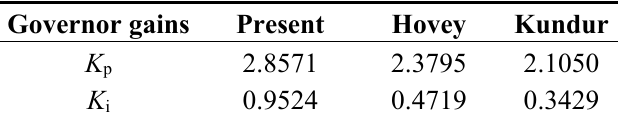
Table 2. Governor gains used in the